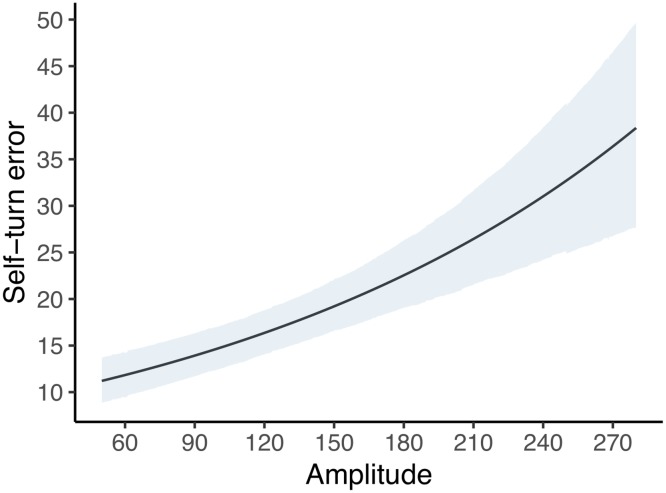
Predicted mean of self-turn error according to amplitude (nparticipants = 49; nobservations = 578).The line represents the mean value, the shaded area the 95% BCI values.